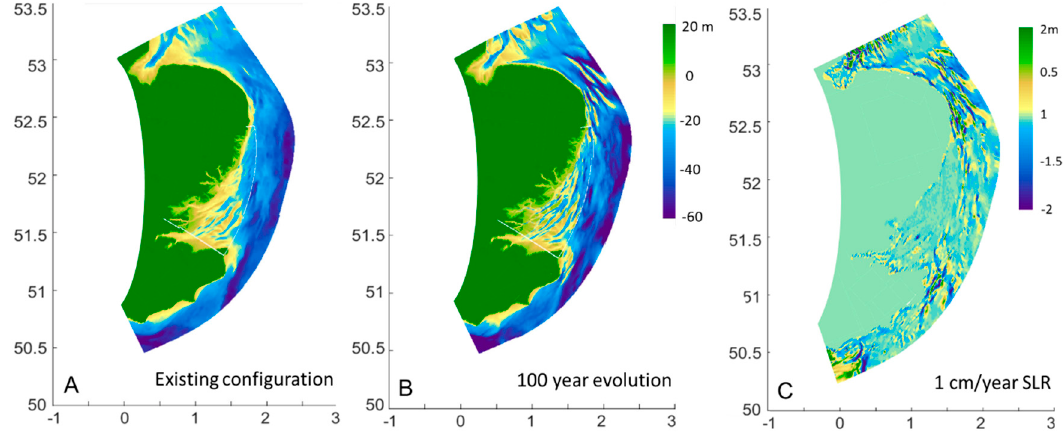
Figure 2. Initial bed level ( A ); ( B ) bed level after one year simulation with 100 morphological factor; ( C ) Changes in bed level between a 100 years morphologically evolved test case with no-sea level rise and 1 cm/year sea level rise.